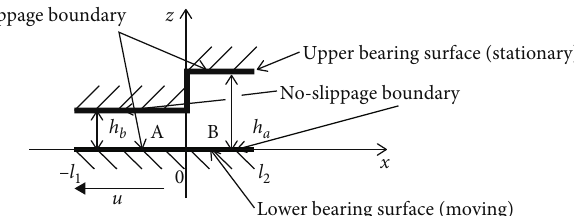
Figure 1: Hydrodynamic step bearing with designed wall slippage [42]. (A) Fluid outlet zone, (B) fl uid inlet zone, and ( u ) moving